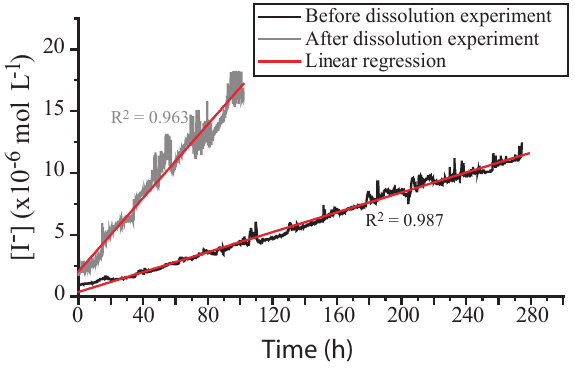
Figure 5. Iodine concentration measured in the sink cell during dif- fusion experiment through sample Bvl before and after the dissolu- tion